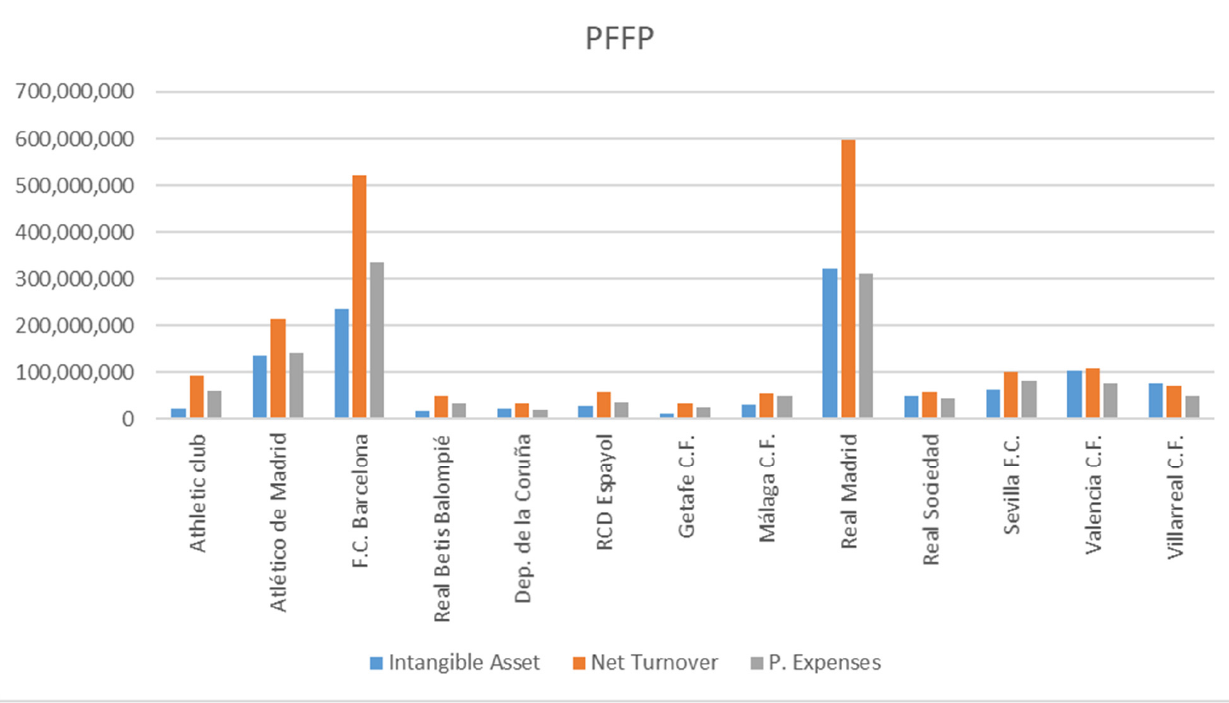
Figure 3. Comparative by club PFFP.